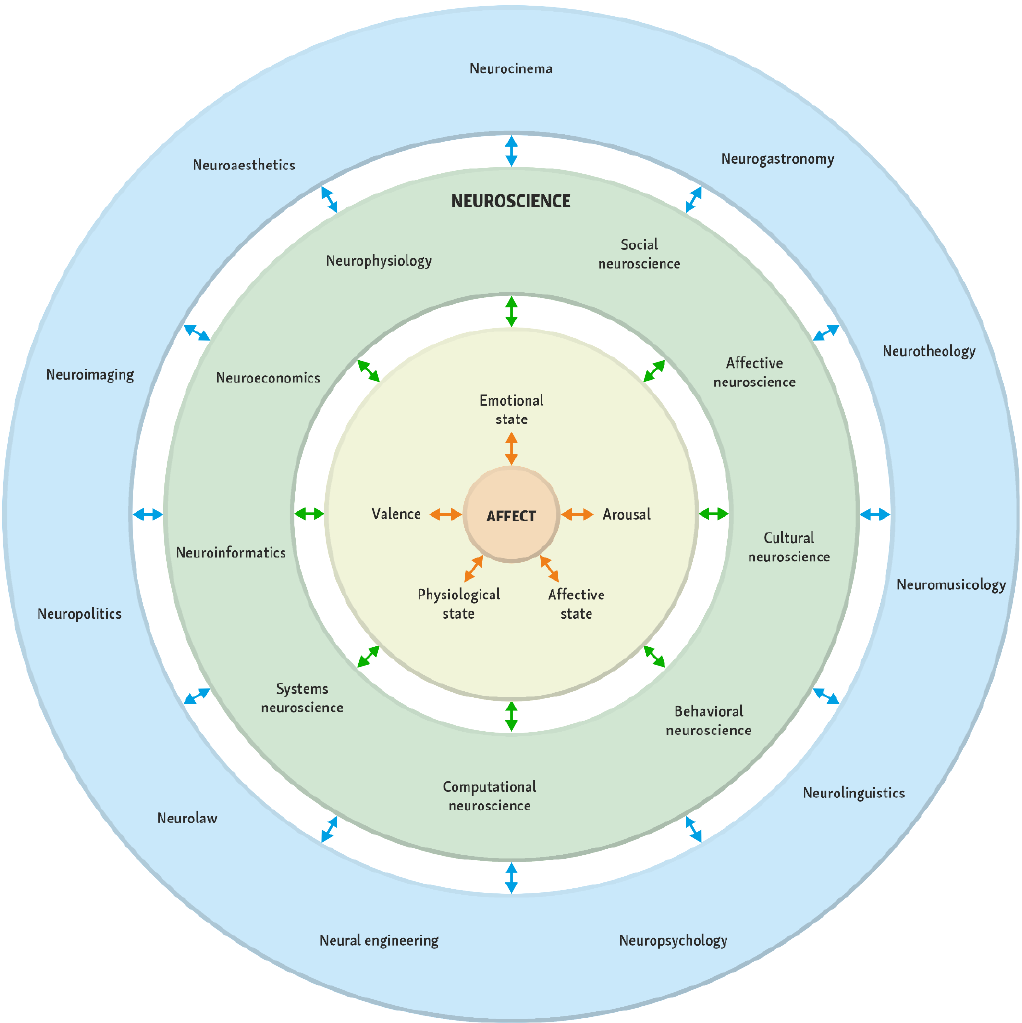
Figure 2. Neuroscience and biometric branches analyzing AFFECT in various sciences and fields.